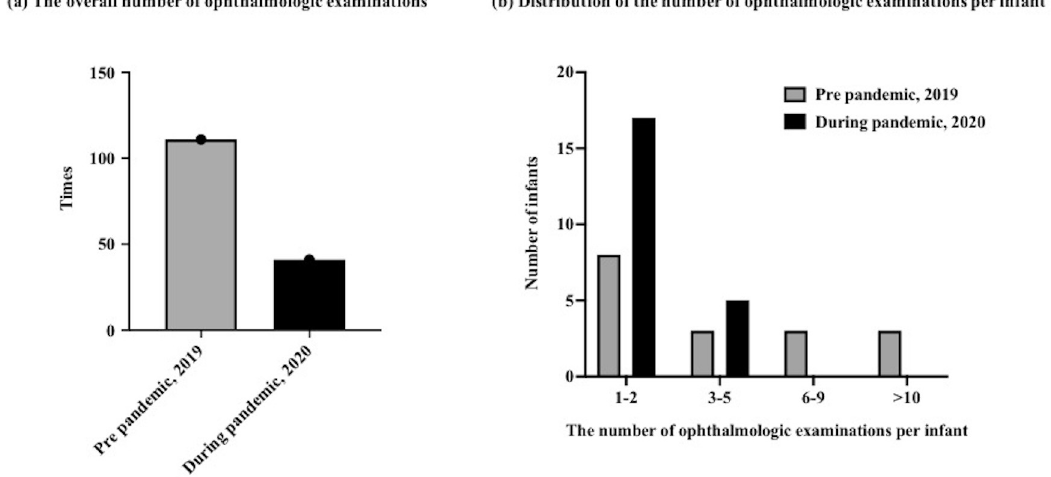
Fig 1. Number of ophthalmologic examinations. (a) Overall number of ophthalmologic examinations. (b) Distribution of the number of ophthalmologic examinations per infant.